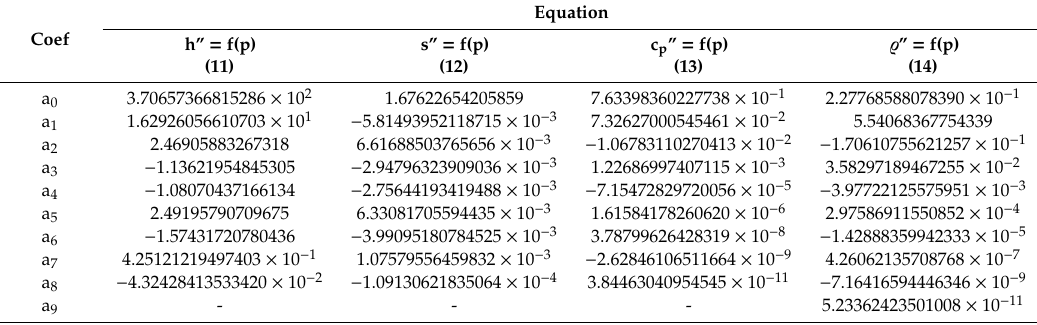
Table 6. Coe ffi cients of polynomials describing the specific enthalpy, specific entropy, specific heat, and density of the R1234ze(E) refrigerant in the saturated vapour state. Equation Coef h” = f(p) s” = f(p) (11)